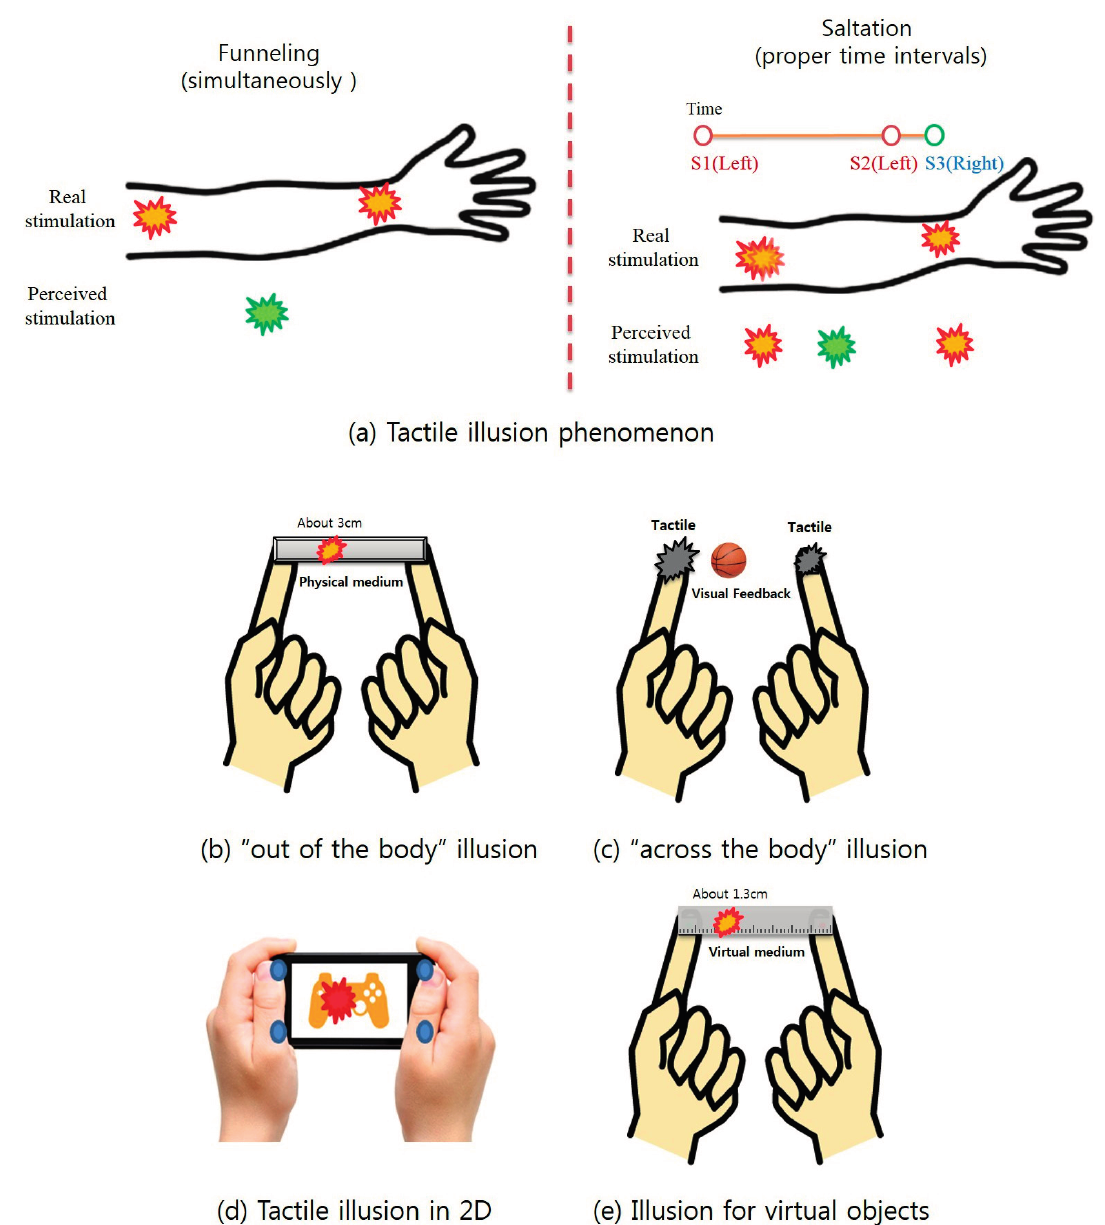
Figure 1. ( a ) Illustration of the two main illusory tactile sensations (funneling and saltation) [5,6] and recent extensions: ( b ) “out of the body” illusion (tactile experience from a hand-held physical medium) [10]; ( c ) “across the body” illusion (e.g., between hands of separate limbs) [11]; ( d ) 2D modulation for hand-held mobile interaction [12]; and ( e ) illusion for augmented object (tactile interaction using both tactile illusion (funneling/saltation) and virtual visual feedback